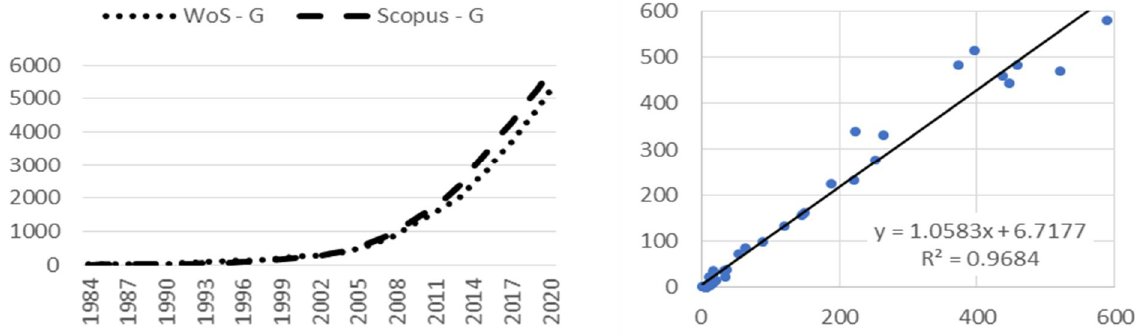
Figure 5. Growth and correlation of citations received by articles on the Water Market. Source: own elaboration.